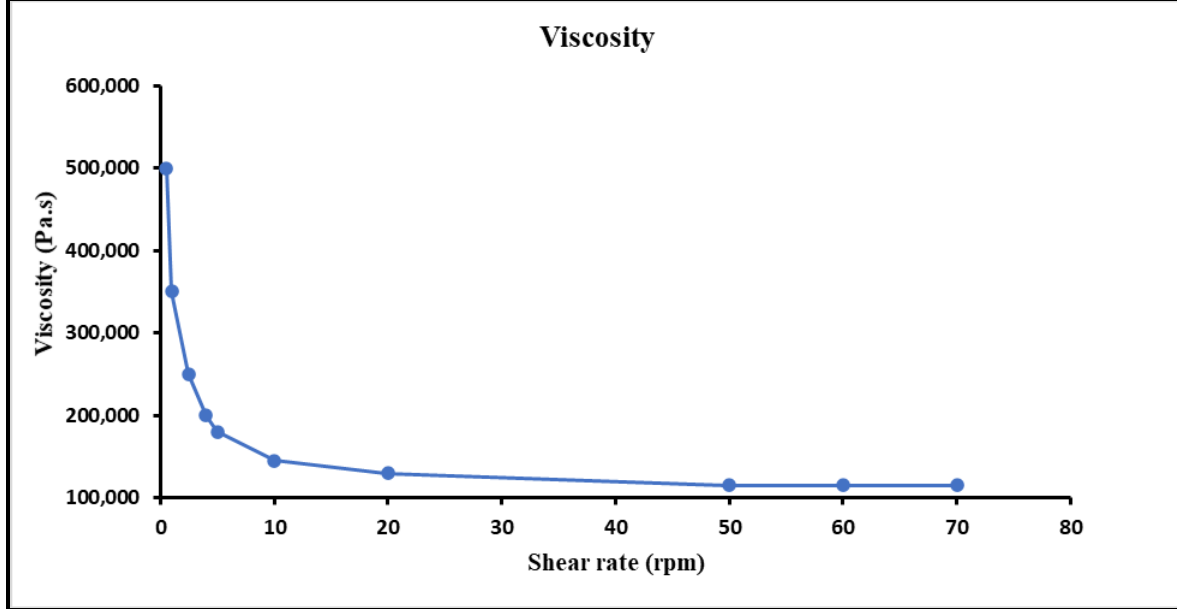
Figure 6. Viscosity of hydrogel at different shear rates and characterization, i.e., pH, extrudability, spreadability and drug content of MTX - NPs loaded hydrogel.